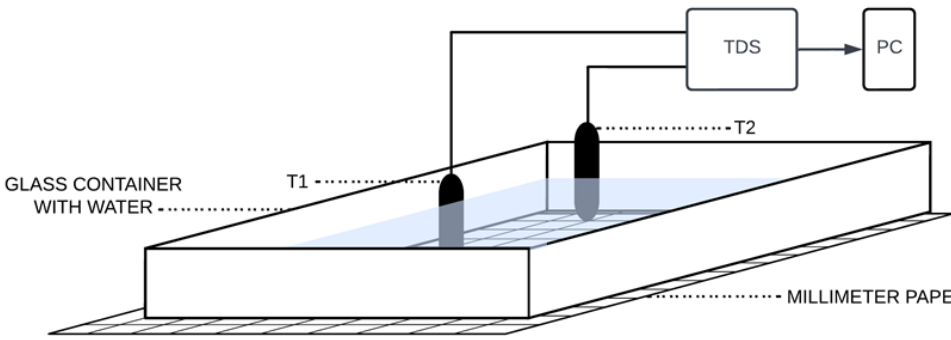
Figure 2. Schematic diagram of the arrangement of sensors in the thermodynamic system in the second part of the pilot experiment.